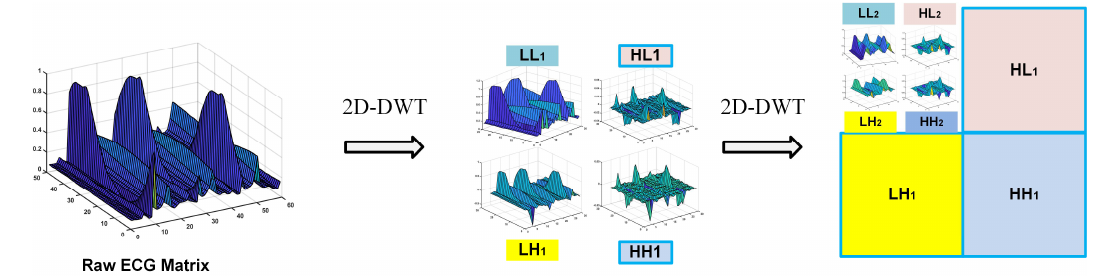
Figure 3. One-level wavelet transform for image.